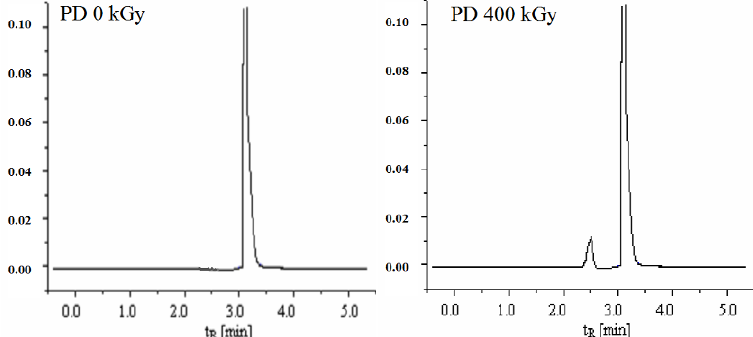
Figure 4. Chromatogram HPLC of pindolol before and after irradiation (400 Table 1. Results of quantitative analysis of PD before and after irradiation. Dose Content [%] [kGy] UV